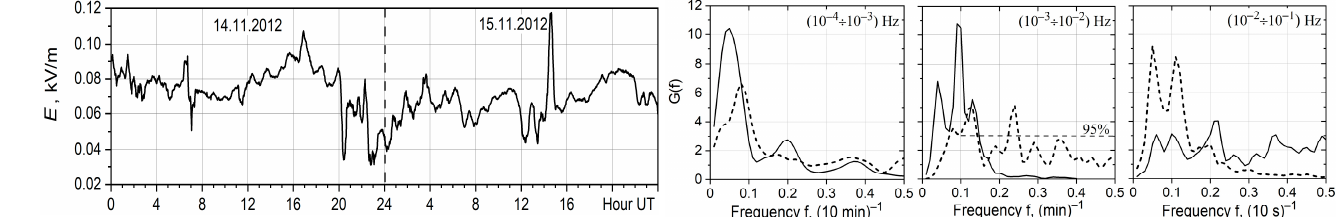
Figure 7. The values of the atmospheric electric field under the impact of the large (Dst = − 103) geomagnetic storm (left panel) and power spectra of variations in the atmospheric electric field during magnetic storms (right panel, dashed line curve).